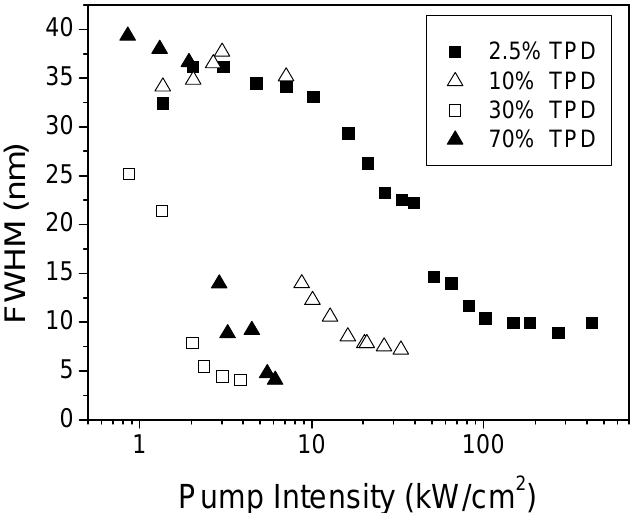
Figure 5. FWHM as a function of pump intensity for PS films doped with various TPD